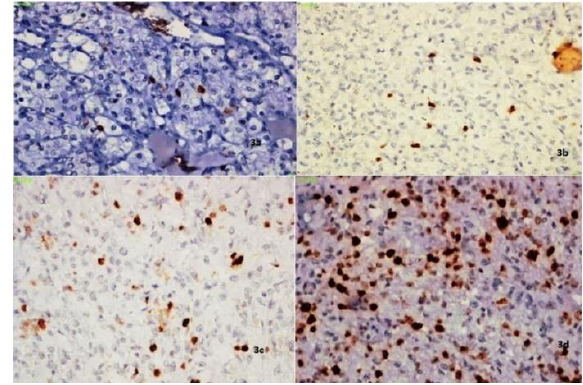
Fig 3. IHC of Ki-67 in clear cell RCC